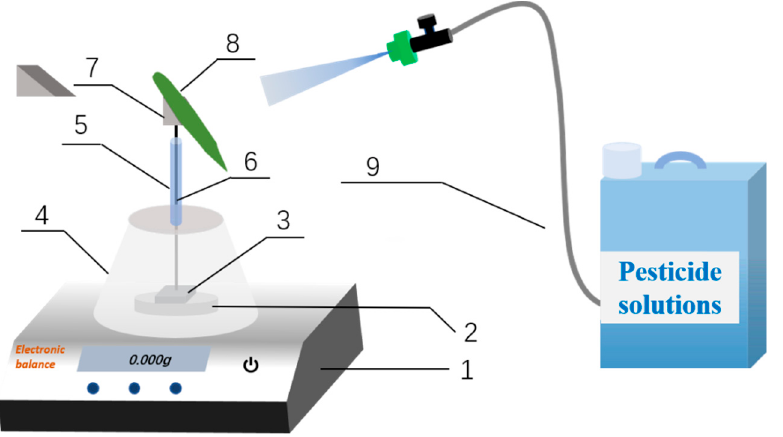
Figure 1. Schematic diagram of the deposition of droplets on leaves for laboratory evaluation. (1) electronic balance, (2) tray of electronic balance, (3) pedestal, (4) droplet isolation cover, (5) trans- parent plastic pipe, (6) strut (connecting stage and base), (7) 30 °, 45 °, 60 ° stage, (8) wheat leaf and (9) spray device.